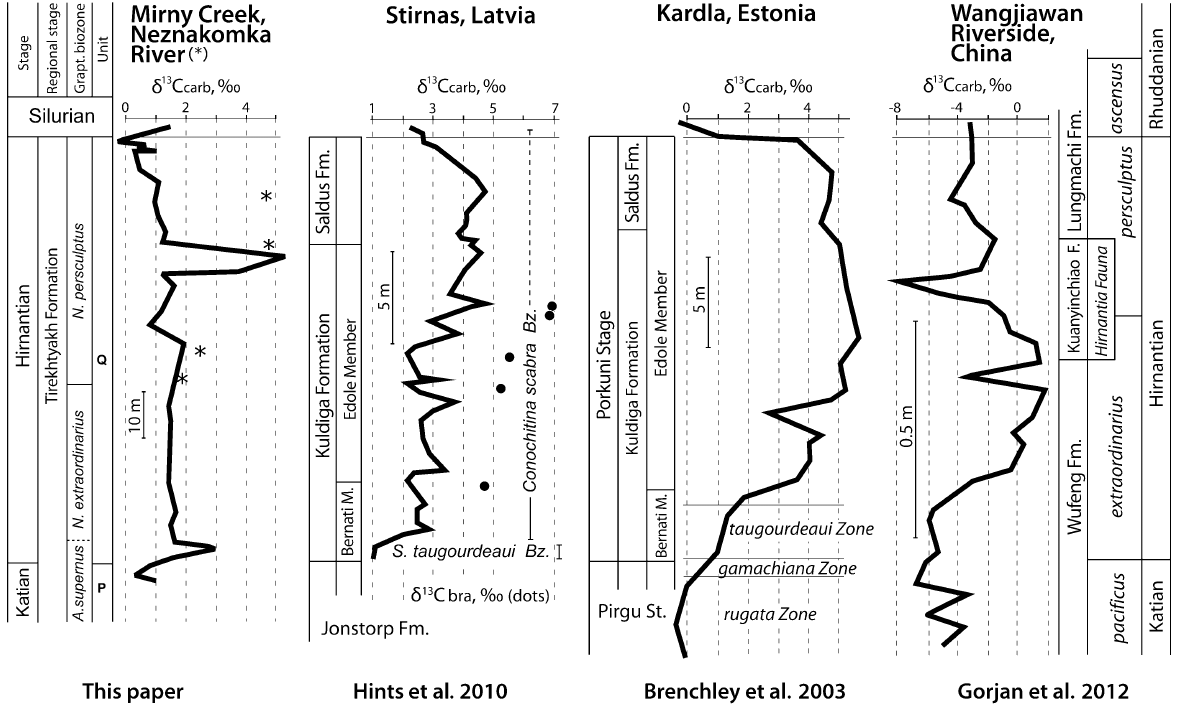
Fig. 6. Comparison of the Mirny Creek area, Baltic and Chinese generalized Hirnantian carbon isotope trends. Note that all curves are modified from originals, the vertical scale of the drawing is unified, differences in thicknesses of rocks can be followed using the scale bar. The Mirny Creek curve was first published by Kaljo & Martma